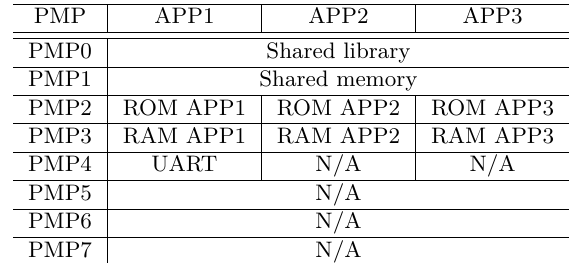
Table 1: PMP usage for rewriting method. N/A implies that PMP entry is disabled. All PMP i is configured by NAPOT.